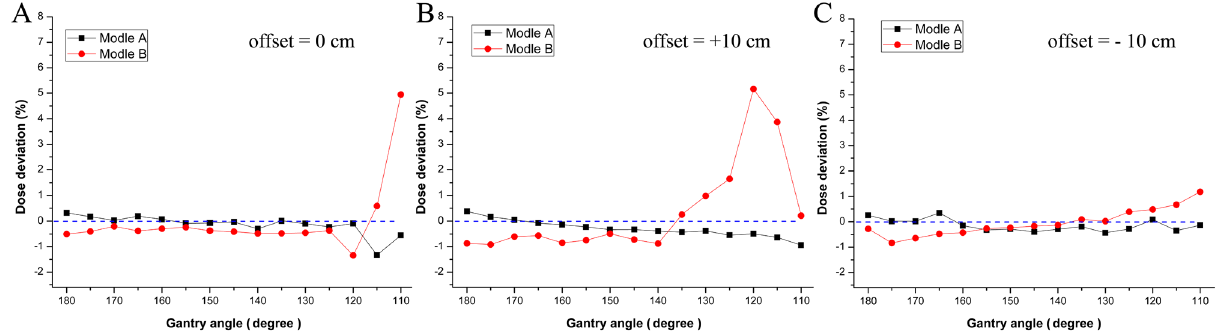
Figure 7. The comparison of the deviation between TPS calculation (MC algorithm) and actual measured isocenter dose for model ( A ) (with authentic CT scanning data of the couch) and model ( B ) (with inserted dummy couch structure data). The blue dash lines indicate actual measured isocenter dose (deviation =